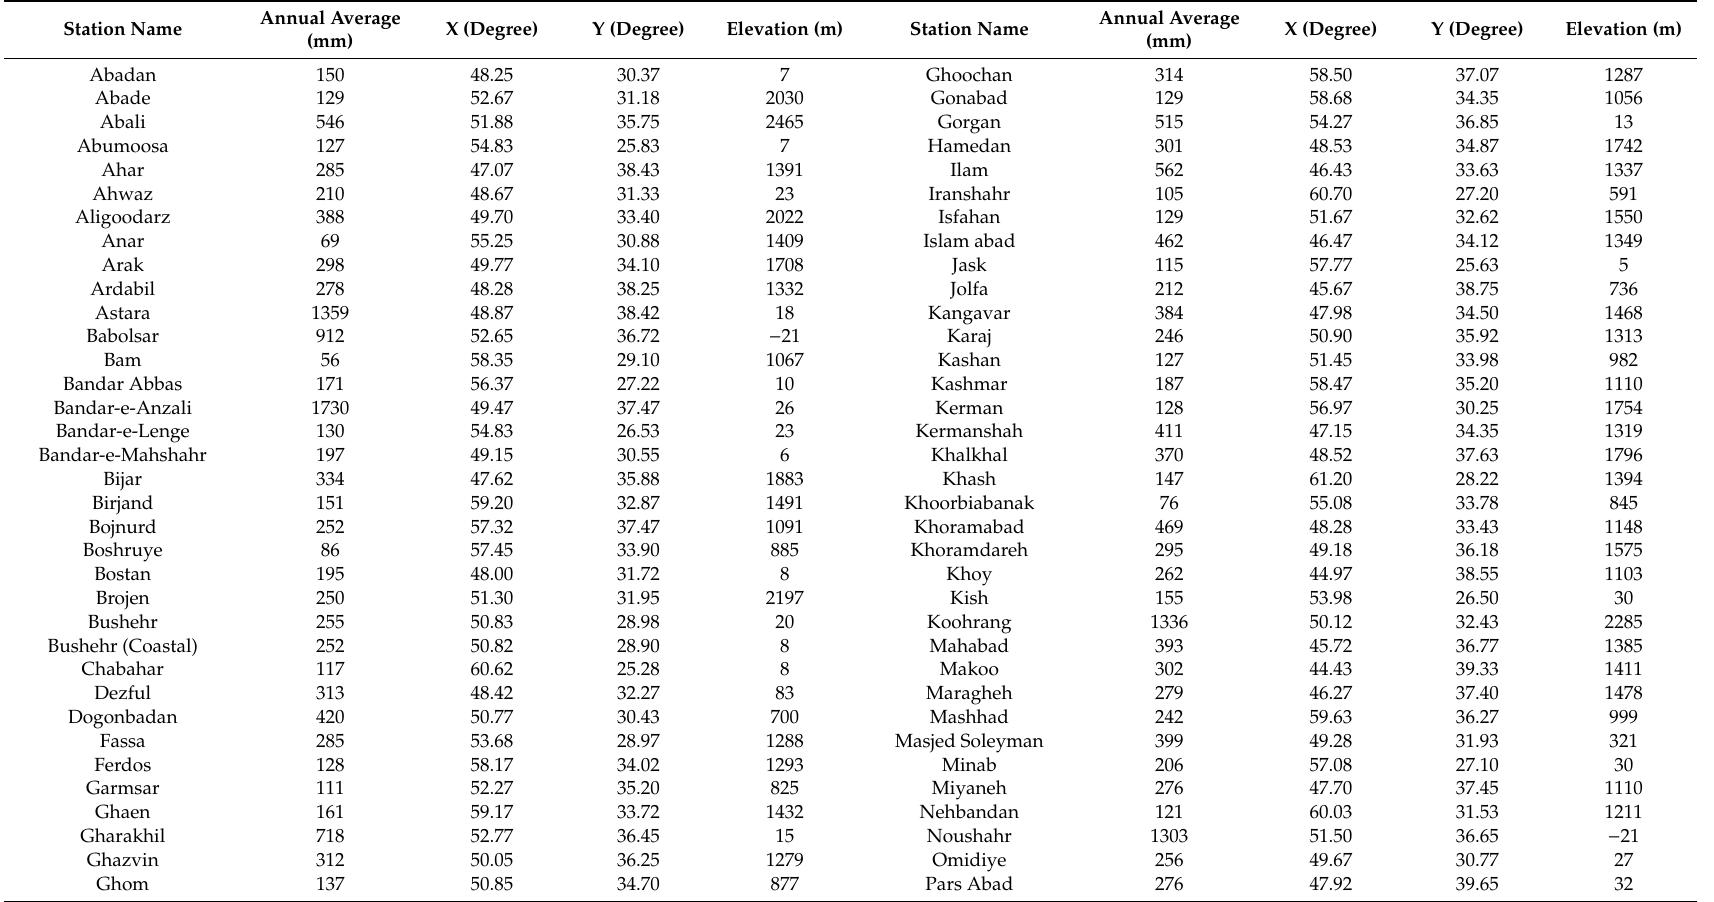
Table A1. Annual average of precipitation in synoptic stations during